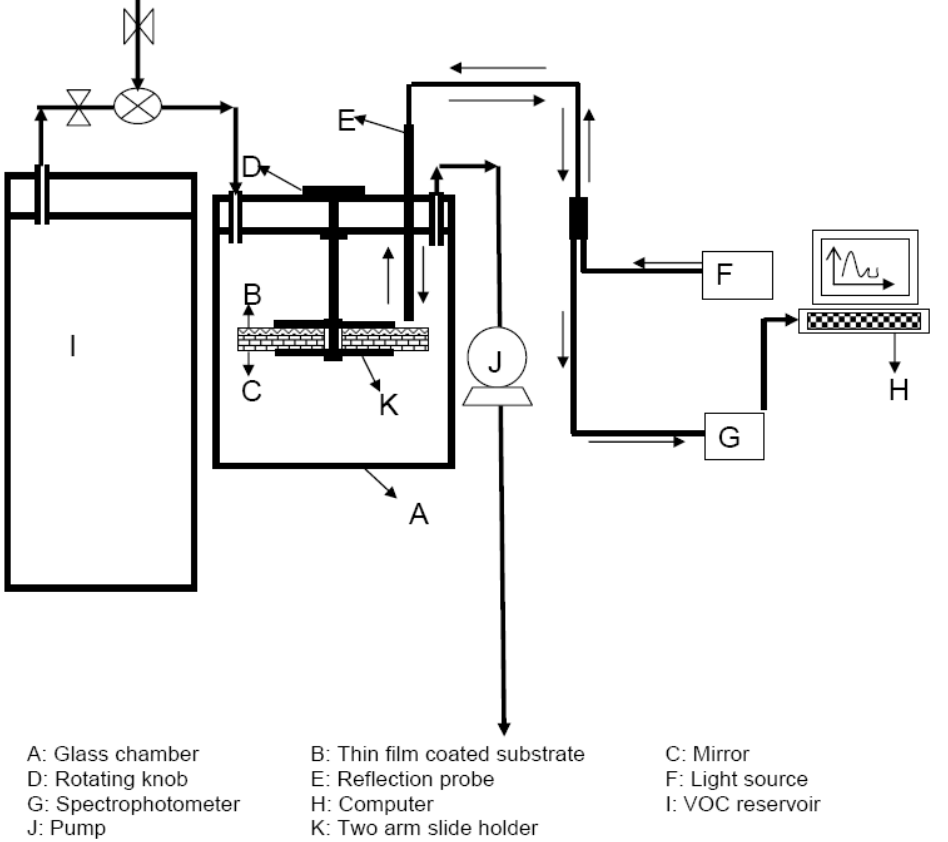
Figure 9. The schematic diagram of opto-electronic nose system for detection of